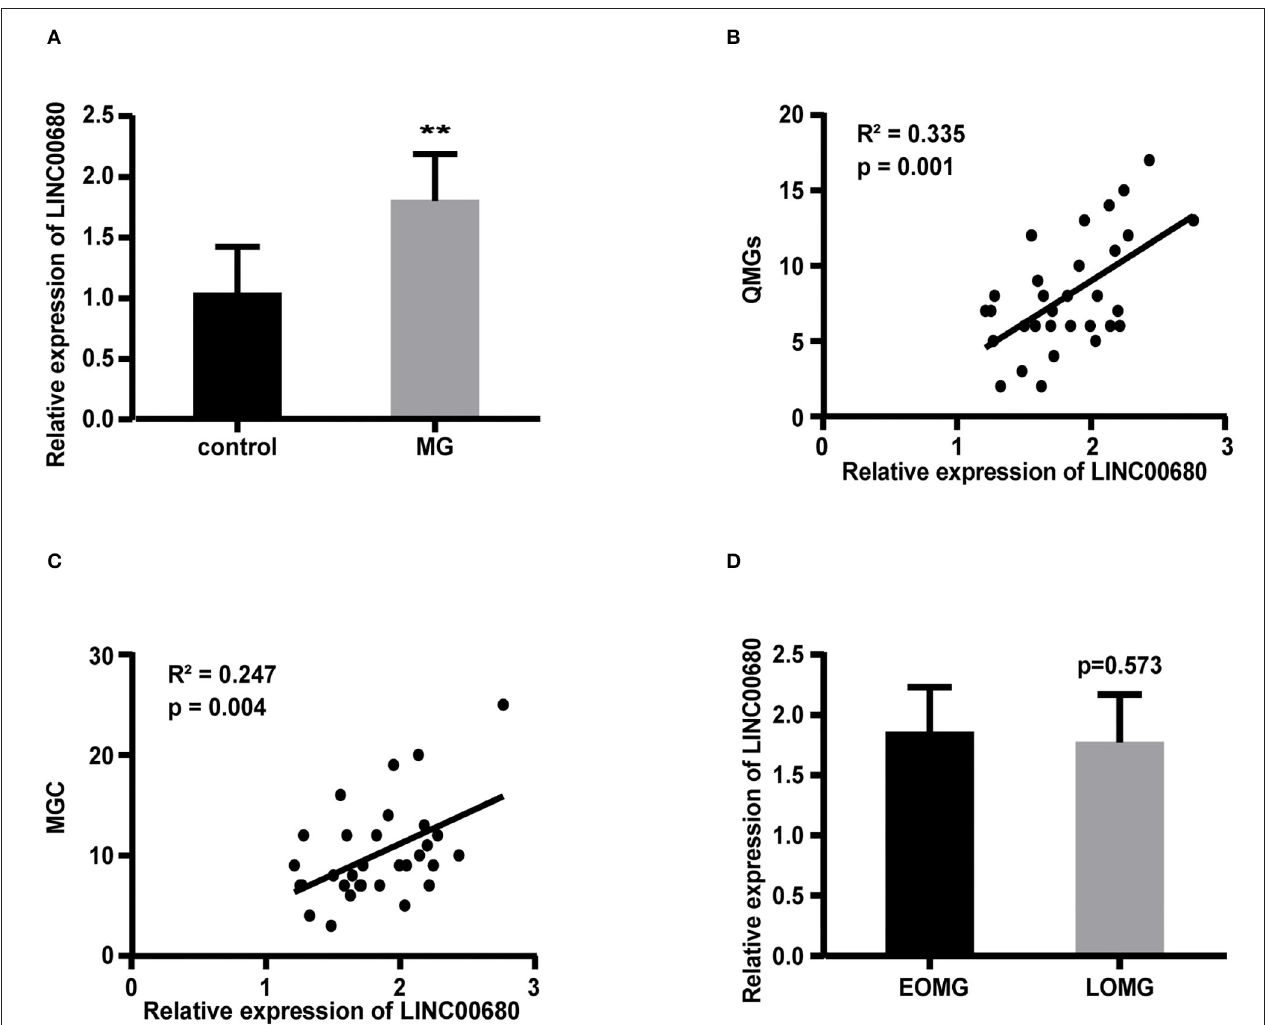
FIGURE 1 | Expression of LINC00680 in MG and its correlation with MG severity and onset age. (A) LINC00680 expression was investigated in 31 patients with MG and 31 control subjects by real-time PCR (B) Correlation analyses between QMGs and LINC00680 expression in patients with MG (C) Correlation analyses between MGC and LINC00680 expression in patients with MG (D) LINC00680 expression did not differ significantly between early-onset MG (EOMG) and late-onset MG (LOMG) ( ** p < 0.01). MG, myasthenia gravis; QMGs, Quantitative MG score; MGC, Myasthenia Gravis